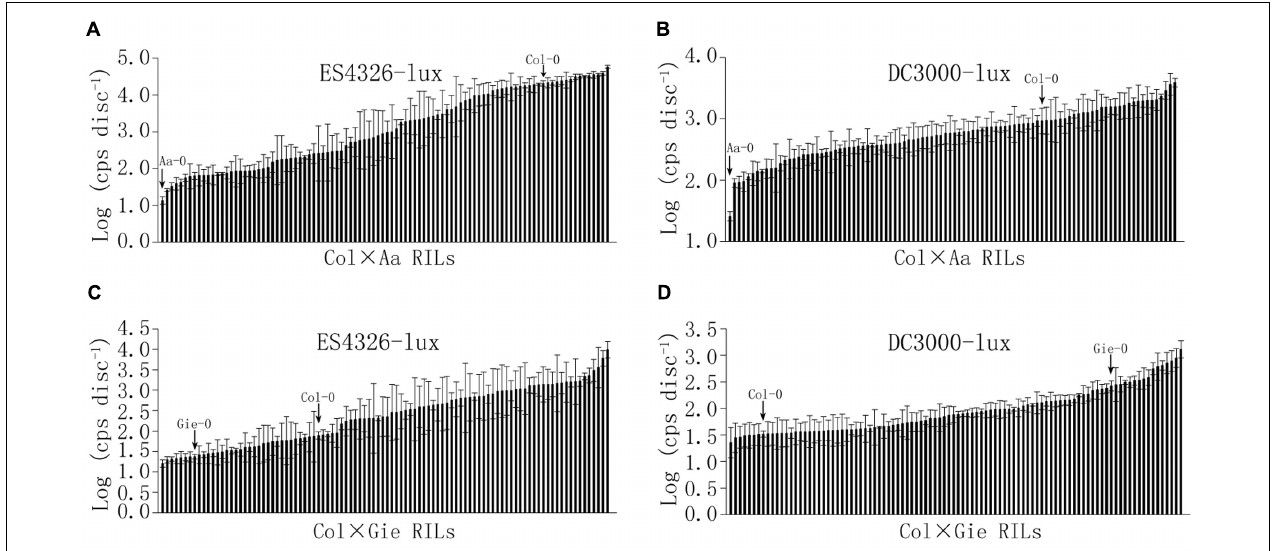
FIGURE 2 | Continuous distribution of sizes of bacterial population among Col × Aa and Col × Gie RILs. Bacterial inocula of optical density (OD 600 ) at 0.003 and 0.0002 were used for Col × Aa RILs and Col × Gie RILs, respectively. Leaf discs from four leaves per line were taken to measure luminescence (photon counts per second) at 48 hpi for Col × Aa RILs (A,B) and 72 hpi for Col × Gie RILs (C,D) . Bacterial titers of parents are indicated by arrows. The experiment was repeated three times and the average levels of luminescence of each line from three experiments are shown. Error bars denote standard deviations ( n =